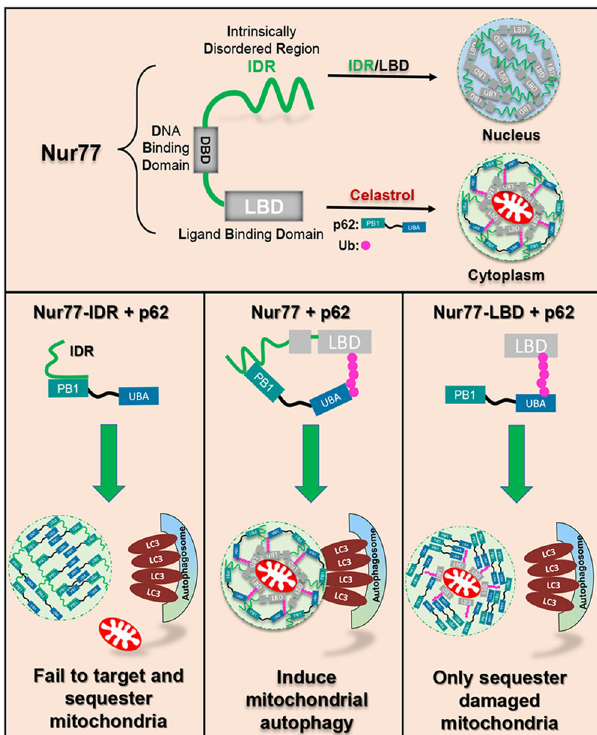
Fig. 8 Graphic summary of Nur77 phase separation and its role in celastrol-induced mitophagy by promoting the liquidity of p62 condensates. The phase separation of Nur77 and p62/SQSTM1 triggered by their multivalent interaction sequesters damaged mitochondria and directs cargo mitochondria to the autophagic machinery. DBD DNA-binding domain, LBD ligand-binding domain, IDR intrinsically disordered region, PB1 Phor and Bem1p, UBA ubiquitin-associating, Ub